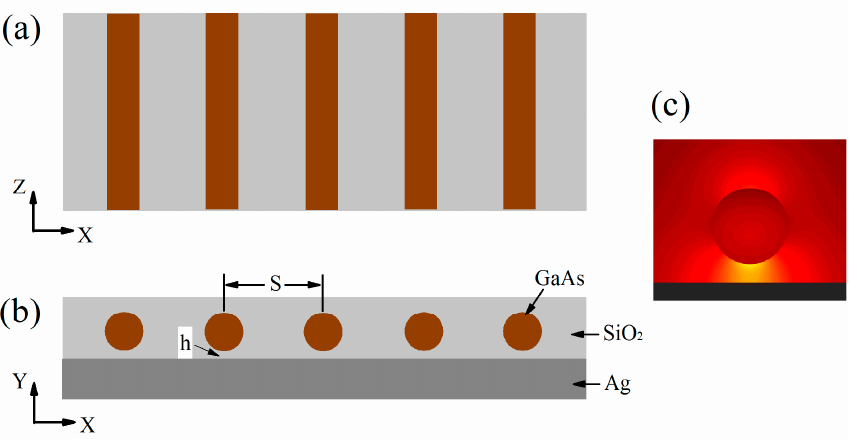
Figure 1. Schemes of five adjacent HPWs. ( a ) The top view of the HPWs. ( b ) The front view of the HPWs. The HPWs consist of GaAs nanowires embedded in SiO 2 dielectric. The diameter of the GaAs nanowire was 200 nm and the gap was h = 50 nm. The distance between adjacent waveguides was S = 500 nm. ( c ) The field distribution of the plasmonic mode for the single HPW. We numerically simulated the propagation behavior of SPPs in five HPWs by the 3D FDTD method. The grid size was dx = dz = 10 nm and the time increment was ∆ t = ∆ s/2c. A perfectly matching layer was adopted to absorb the outgoing electromagnetic wave around the computational